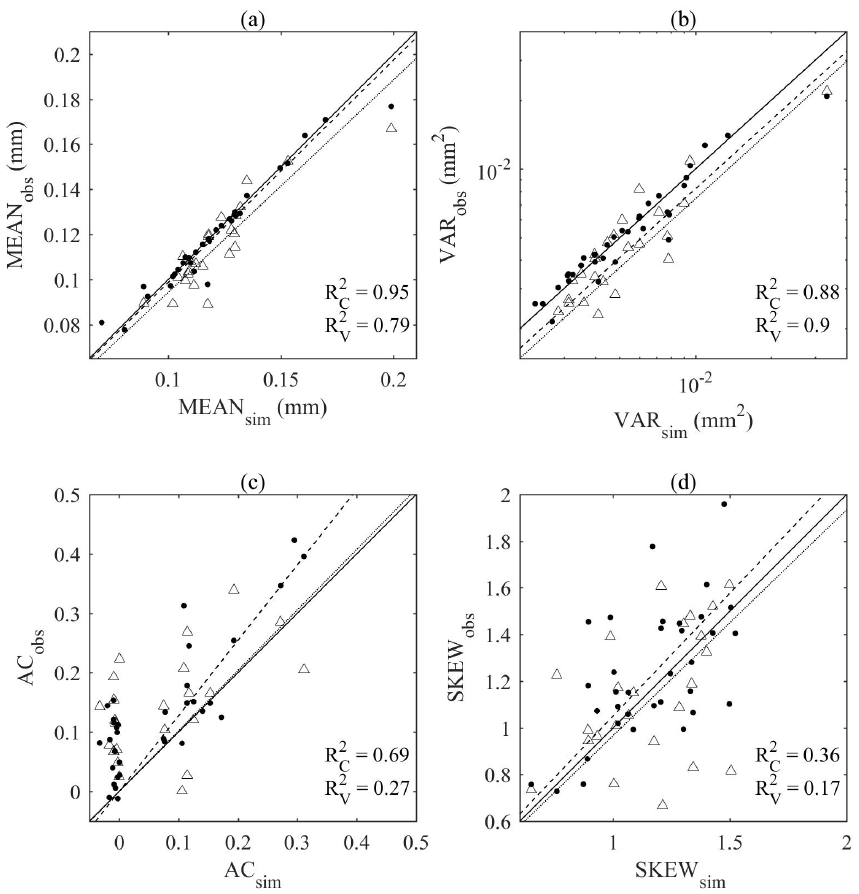
Figure 9. Comparison of (a) mean, (b) variance, (c) lag-1 autocorrelation, and (d) skewness of the synthetic ( x ) and observed ( y ) monthly rainfall. Filled circles (dashed line) and hollow triangles (dotted line) correspond to the calibration (1981–2010) and validation period (1951– 1980)